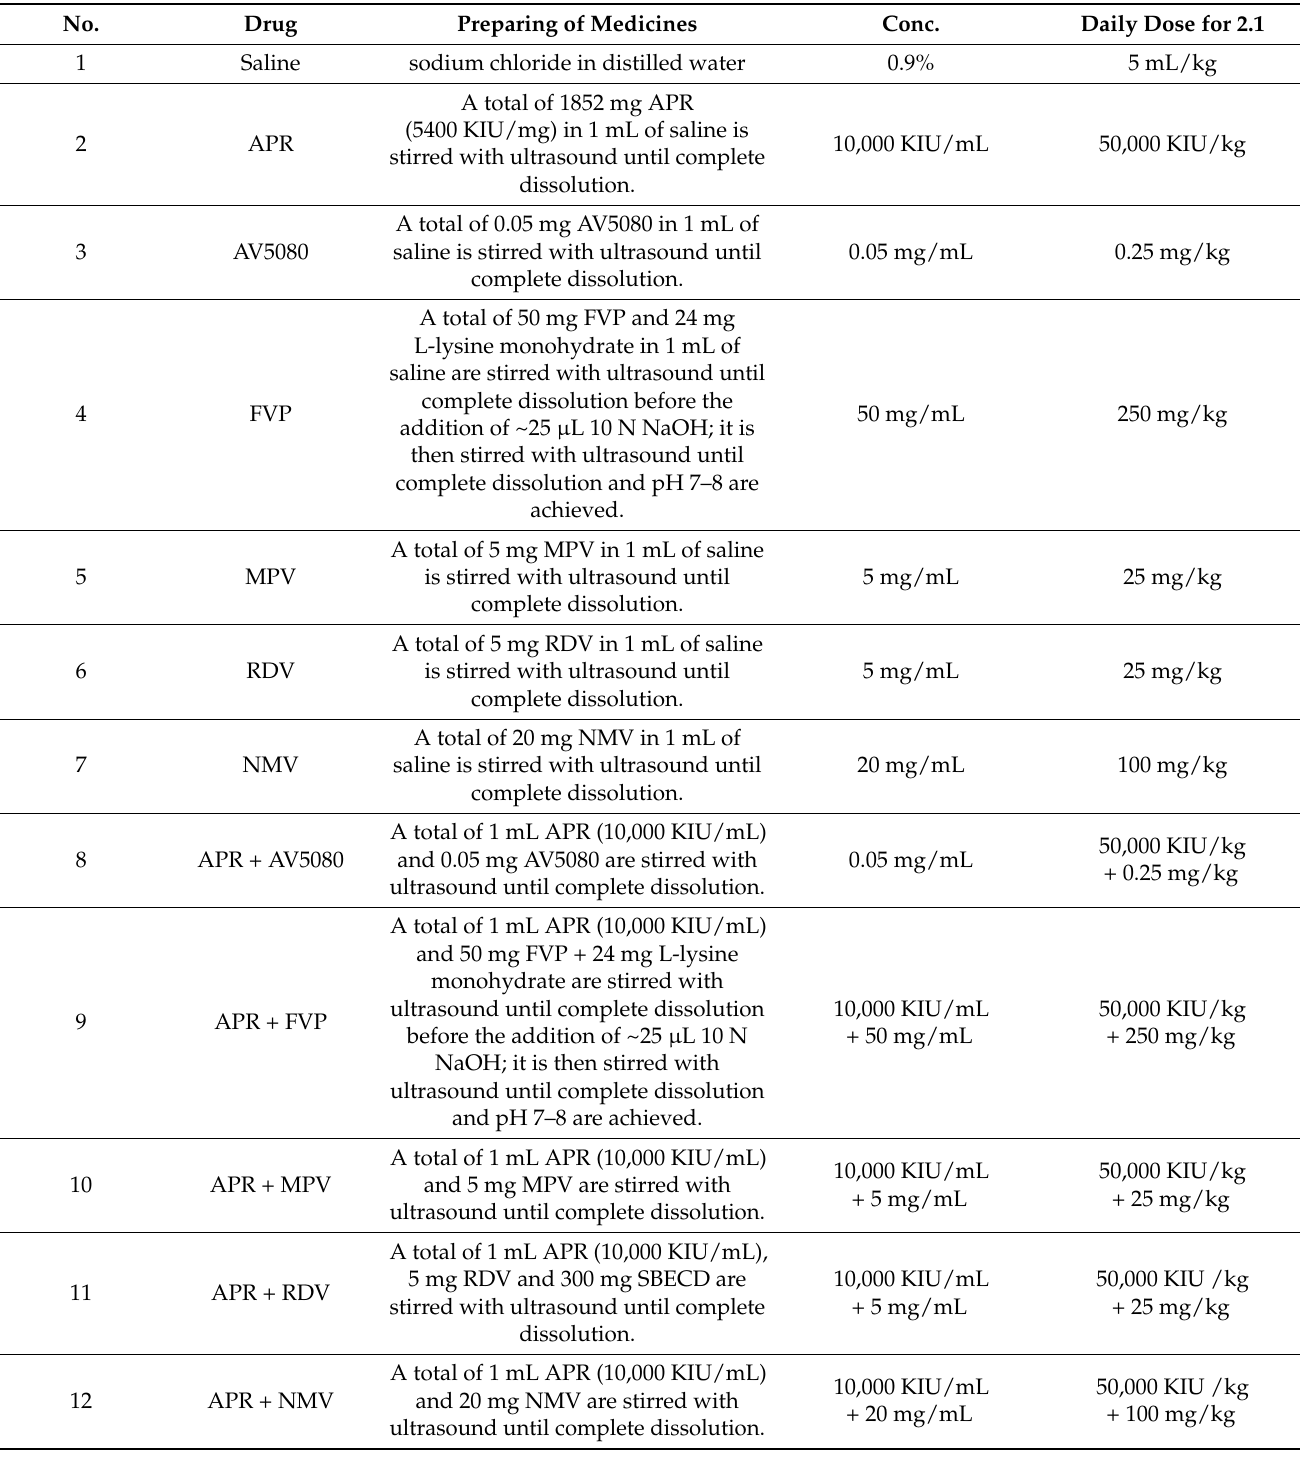
Table 3. Methods of medicine preparation for intraperitoneal administration to mice and drug doses in the mouse influenza pneumonia model and in a model of coronavirus infection